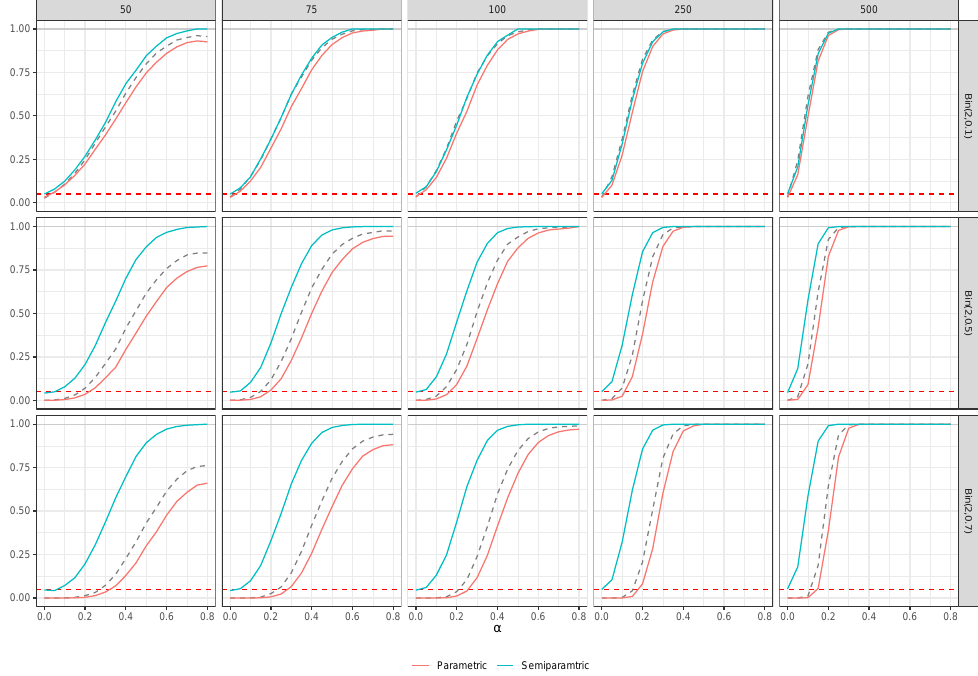
Figure 4. Empirical power of the bootstrap-based score test under binomial DGP. The black dashed line is the empirical power of the asymptotic test, while the red dashed line represents the nominal level of